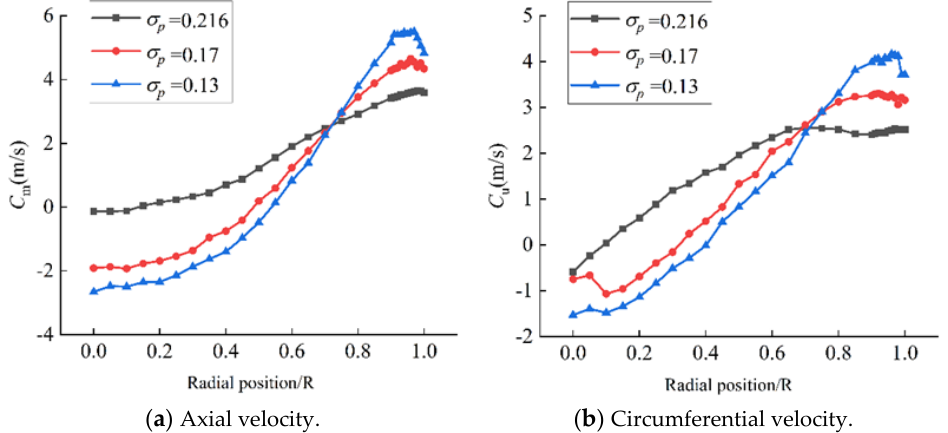
Figure 12. Draft tube velocity distribution for different cavitation coefficients under turbine mode.